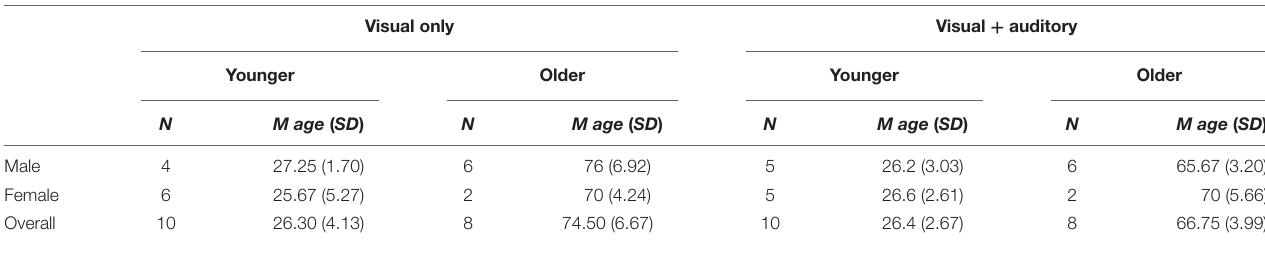
TABLE 1 | Participant demographics by age and sensory